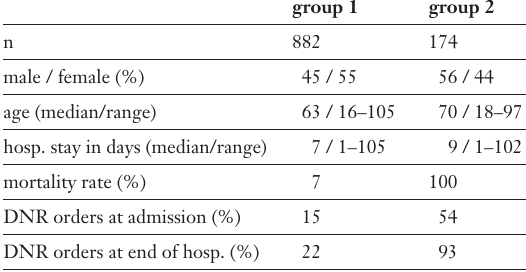
Demographic data of population